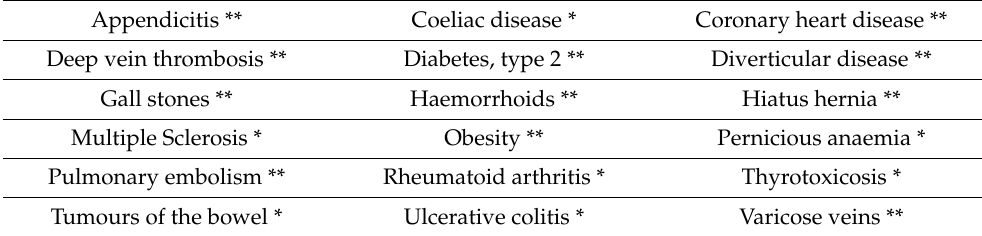
Table 1. Selected Westernized dietary fibre-related diseases specified by Burkitt, and their characteri- sation into the primary cause according to the microbiome function deficiency